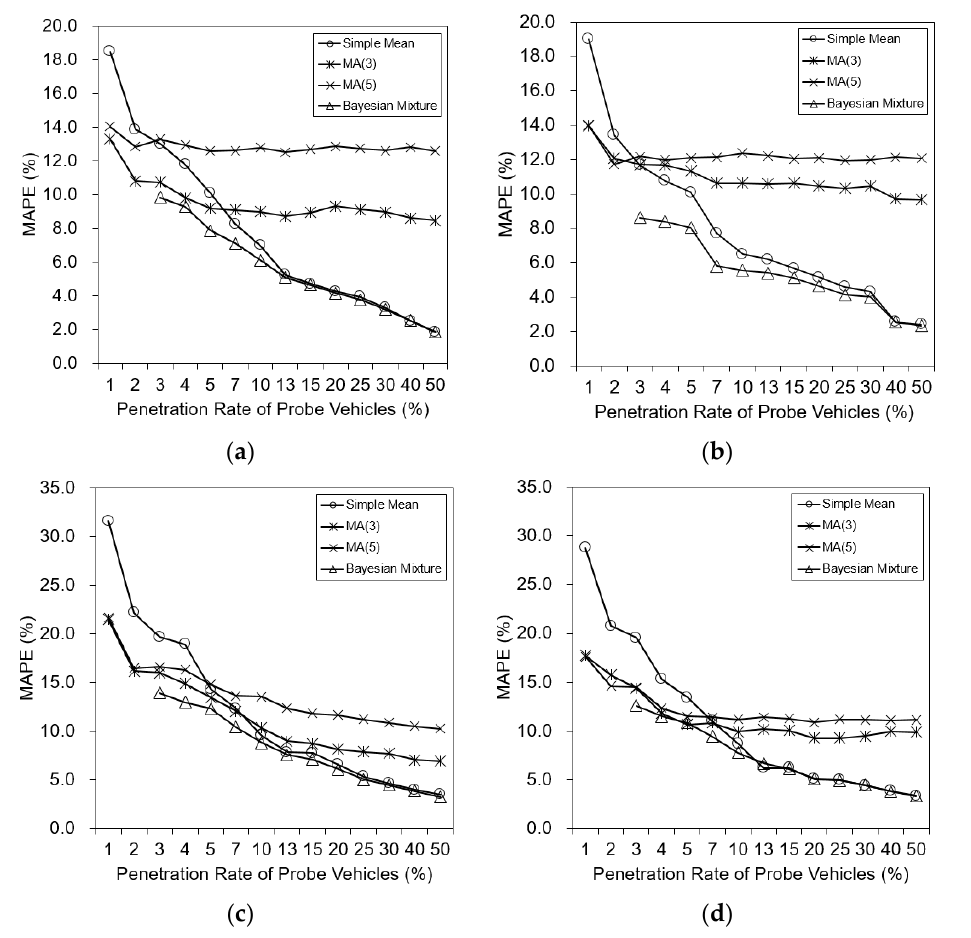
Figure 2. MAPE by different penetration rates of probe data: ( a ) Case I, 29 April 2017, ( b ) Case II, 29 April 2017, ( c ) Case I, 5 May 2017, ( d ) Case II, 5 May 2017. Table 2. Estimation results by different methods during peak